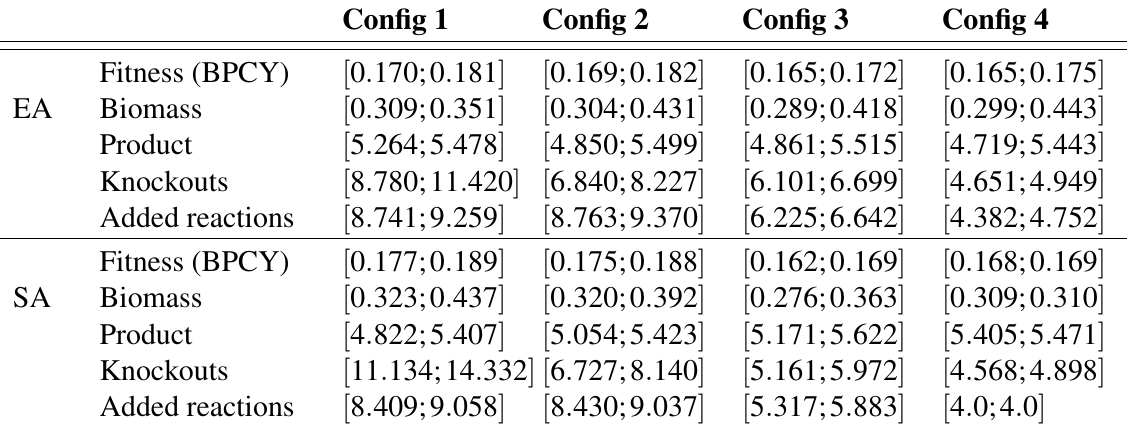
Table 2: The 95% confidence interval of results obtained in the optimization